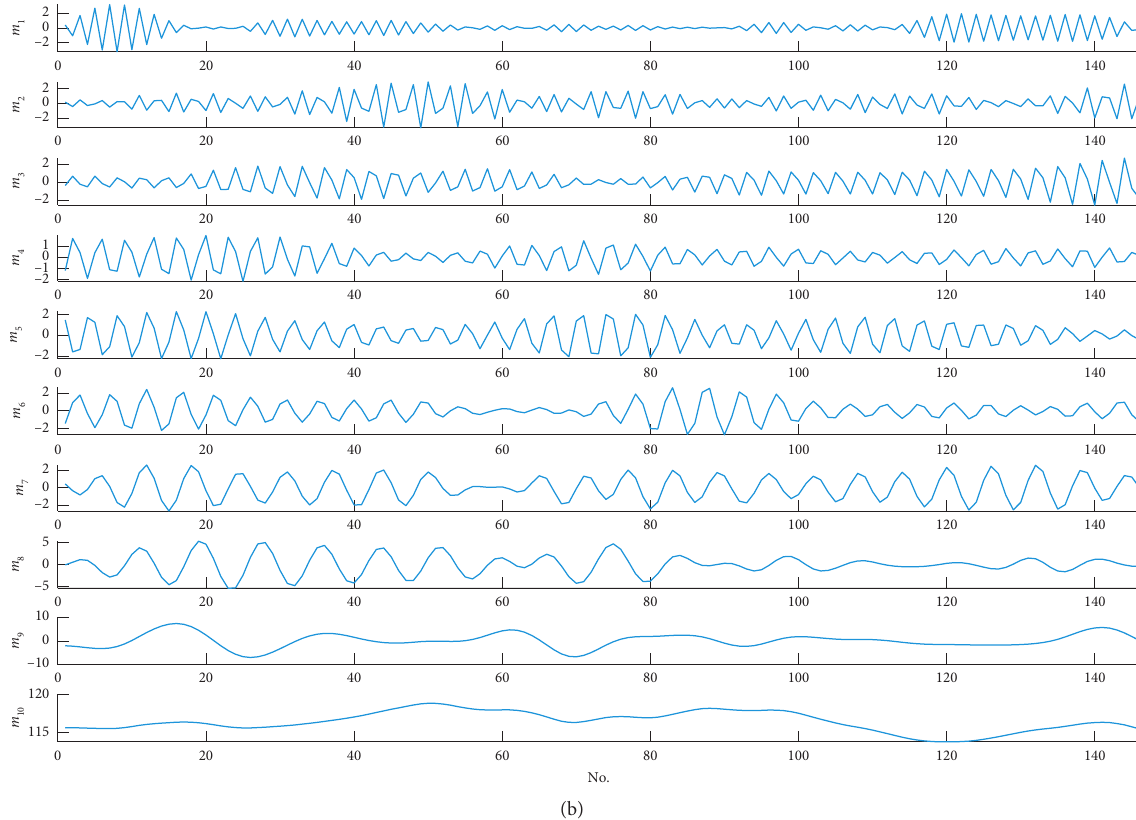
Figure 8: Subseries of the vibration signal decomposed by (a) empirical mode decomposition (EMD) and (b) variational mode de- composition (VMD).